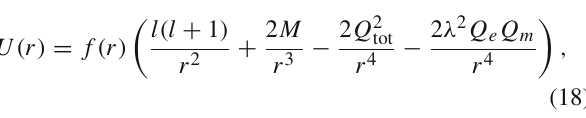
Fig. 1 Unstable regions of the parametric space for the perturbation scalar field based on the condition (21) from integral of the